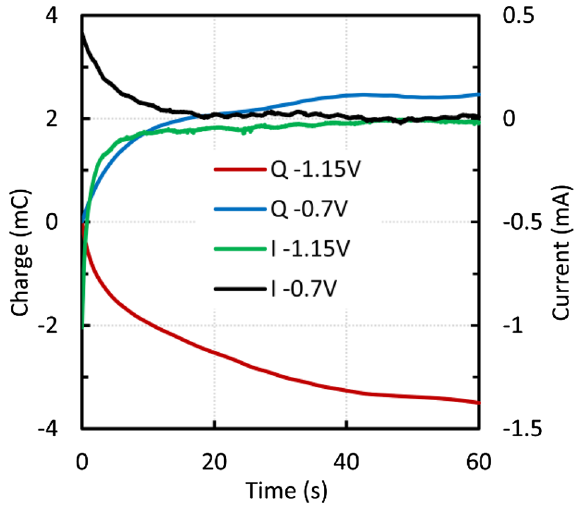
Figure 11. Micromagnetite—chronocoulometric curves after 10 voltammetric cycles at 50 mV s −1 .